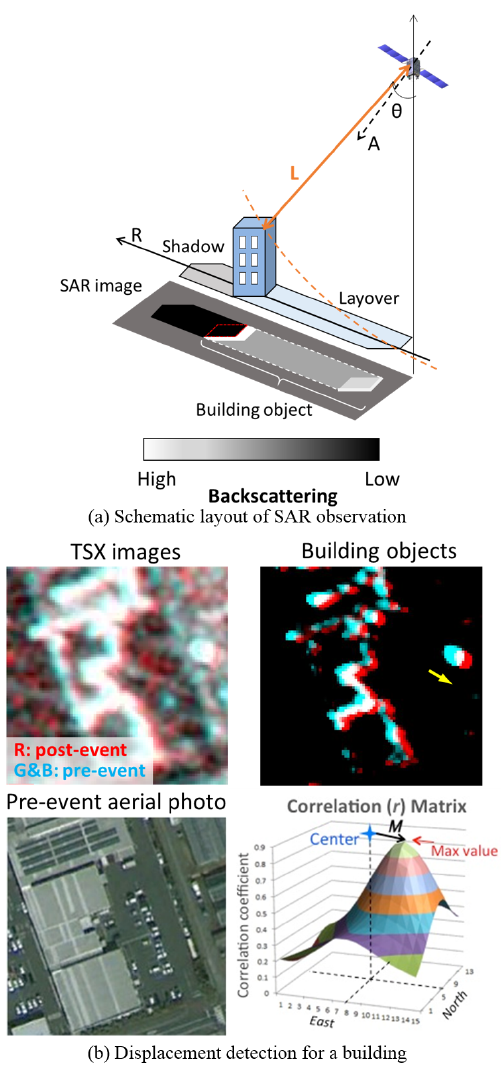
Figure 5. (a) Schematic image of the backscattering intensity of a building captured by a side-looking SAR sensor. (b) An example of displacement detection from a non-damaged building by the cross- correlation